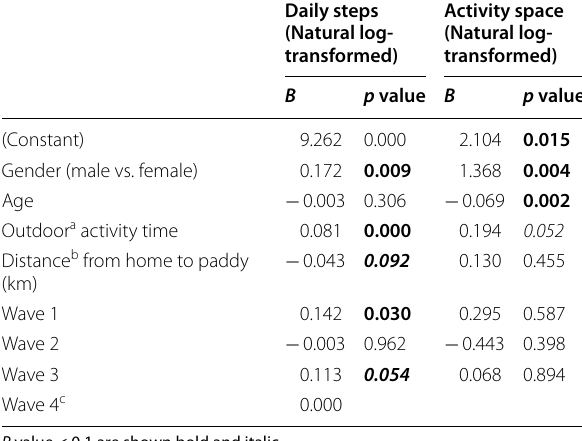
Table 6 Linear mixed model results (fixed effect)—daily steps and activity